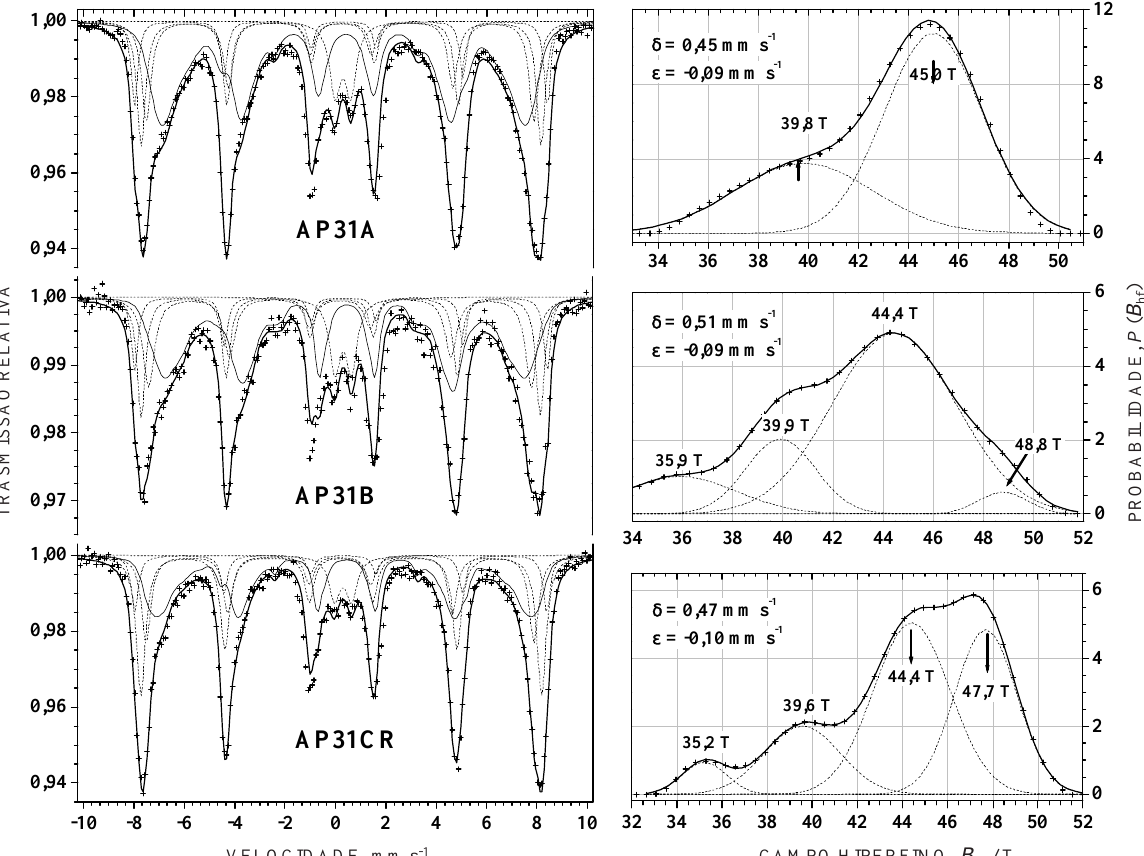
VELOCIDADE, mm s Figura 5. Espectros Mössbauer obtidos à temperatura do ambiente (~298 K) para as amostras de concentrados magnéticos das frações areia do perfil AP31.